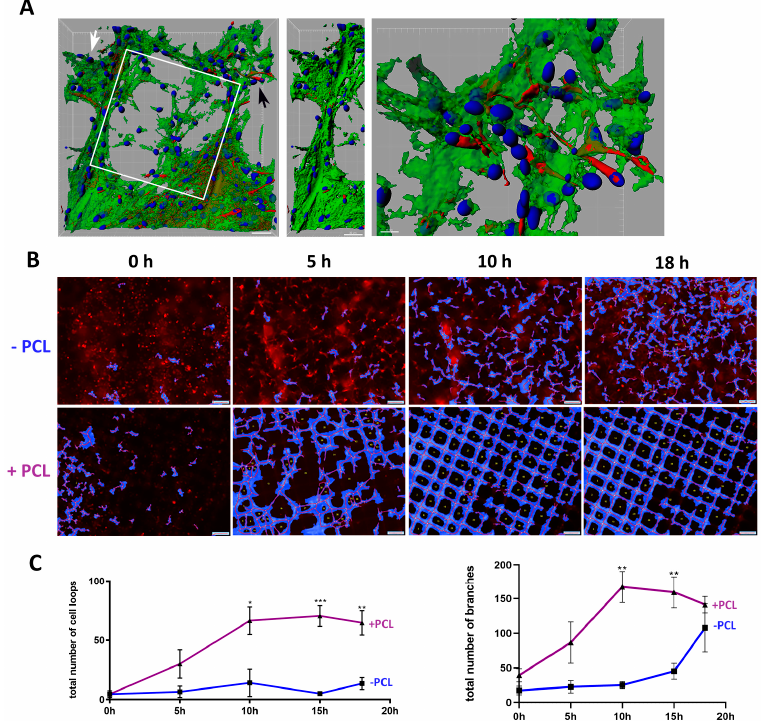
Figure 2. U87 durotaxis and cell network formation with scaffolds in 3D cultures. ( A ) Left image of a 3D reconstruction of an immunocytochemical staining of U87 cells at day 6 with 4.5 mg mL − 1 Matrigel and a single box pore (200 μ m) scaffold (white solid square) (white scale bar = 30 μ m) (ß ‐ tubulin, green; MAP2, red; Hoechst 33342, blue nuclei). The middle image shows the same region from the left image (white arrow) but without the scaffold to show the wrapping of U87 cells around the aligned microfibers. The right image is a magnification of the left image (black arrow) to demon ‐ strate U87 cell interactions at day 6 (right scale bar = 10 μ m) (ß ‐ tubulin, green; MAP2, red; Hoechst 33342, blue nuclei). ( B ) Cell network formation assay. U87 ‐ td ‐ farnesyl expressing cells grown in 3D with 4.5 mg mL − 1 Matrigel alone (minus (–)PCL above) or with a scaffold (+PCL bottom) and imaged over time up to 18 h. Images were analyzed for cell branches or loop ‐ like structures (blue with red lines) using the WimTube computer program. White scale bar = 200 μ m. ( C ) Graphs show cell net ‐ work formation assay (+PCL) scaffolds top red line ( n = 6 experiments) and ( ‐ PCL) scaffolds bottom blue line ( n = 8 experiments) quantified as the total number of cell loops (left graph, Y ‐ axis) and branches (right graph, Y ‐ axis) formed over 18 h. Significance was found comparing +PCL to ‐ PCL; cell loops at 10 h * p = 0.0113; 15 h *** p = 0.0007; 18 h ** p = 0.0023; cell branches at 10 h ** p = 0.002; 15 h ** p = 0.0079). Previously it was shown that the stiffness of Matrigel (at 4.5 mg mL –1 ) represents a soft matrix of <100 Pa (Young’s modulus), but scaffolds exhibited a high stiffness of ~15 kPa [41,42]. A combination of hydrogel with scaffolds positively influences the overall handling by increasing stiffness synergistically [41,42]. In general, a higher matrix rigidity activates durotaxis ‐ directed cell migration towards stiffer substrates [50,51]. Using the same conditions as above for Matrigel and scaffolds, we interpret our findings that a du ‐ rotactic tumor cell response is occurring, where U87 cells migrate from a lower stiffness toward a substrate of a higher stiffness, where scaffolds having aligned microfibers rep ‐ resent a strong physical cue (Figures 1 and 2). However, our findings demonstrating the wrapping of U87 cells around melt electrowritten fibers also suggest that the fiber topog ‐ raphy affects cell behavior (Figure 2A).